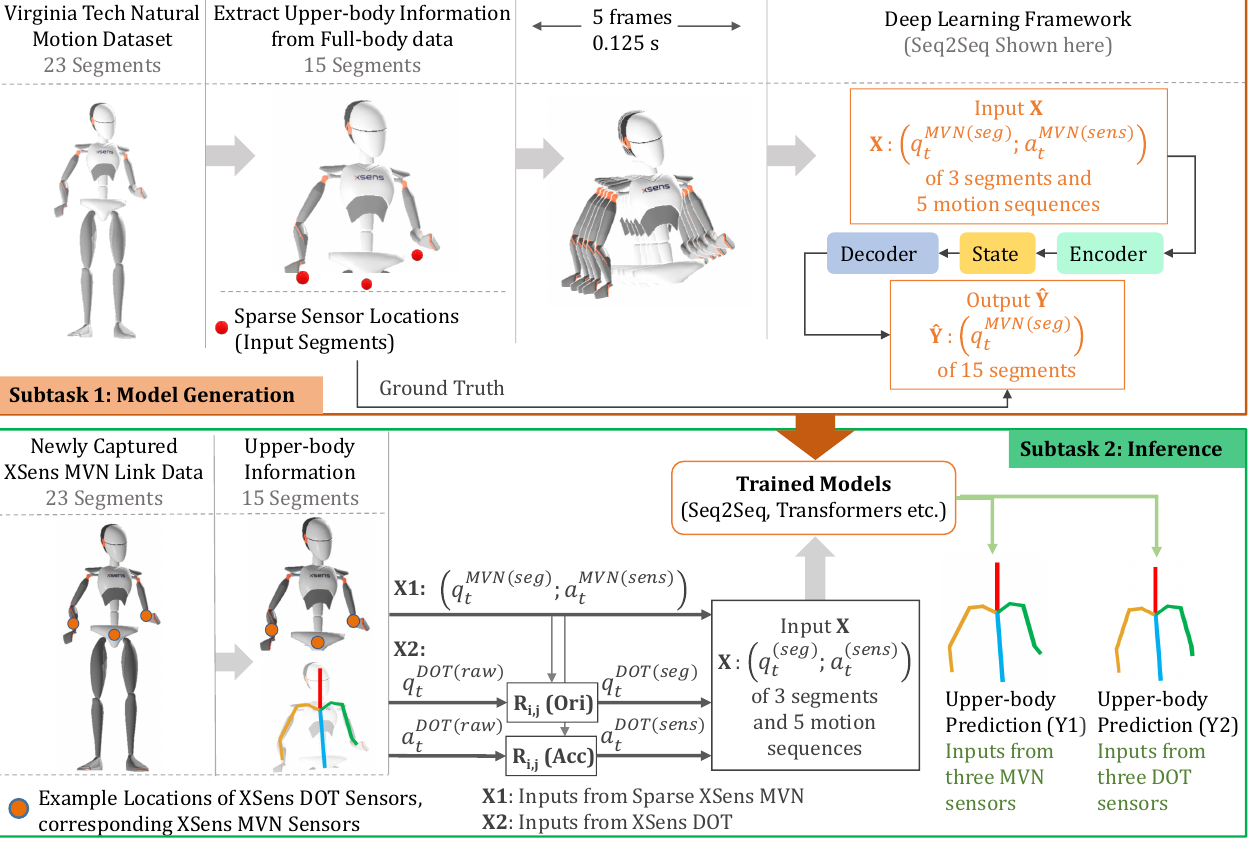
Figure 7. Subtask 1: We used the Virginia Tech Natural Motion Dataset to train our deep learning models. We used three sparse segments (pelvis, right forearm, left forearm), passed five frames ( seg ) ( sens ) of segment orientation ( q MVN ) and sensor linear acceleration data ( a MVN ) into a neural t t network, and then predicted upper body segment orientations for those five frames. Subtask 2: For Inference, we used newly captured XSens data (upper body; 15 segments) for the ground truth. We used two sets of sparse inputs: 3 XSens DOT sensors ( X1 ), and 3 XSens MVN segments ( X2 ). The machine learning models from Subtask 1 produced two sets of output upper body kinematics for the two sets of inputs. We then compared the predicted kinematics with the ground truth upper body information from the newly captured XSens MVN Link data. The data used for inference from ( raw ) the MVN was similar to that in Subtask 1; for the DOT sensors, the raw orientation ( q DOT ) and t ( raw ) acceleration ( a DOT ) were calibrated to match the MVN coordinate system by multiplying with a t rotation matrix R i , j